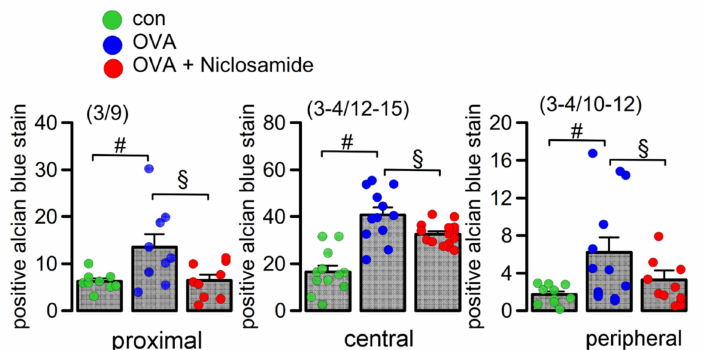
Figure 4. Quantification of airway mucus. Quantification of mucus in proximal, central, and peripheral airways. Mean ± SEM (Number of mice/number of airways analyzed). # significant difference when compared to control ( p < 0.05, ANOVA). § significant difference when compared to OVA ( p < 0.05,